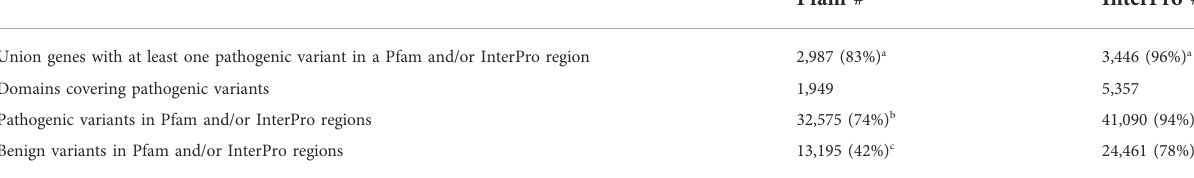
TABLE 2 Pfam and InterPro coverage